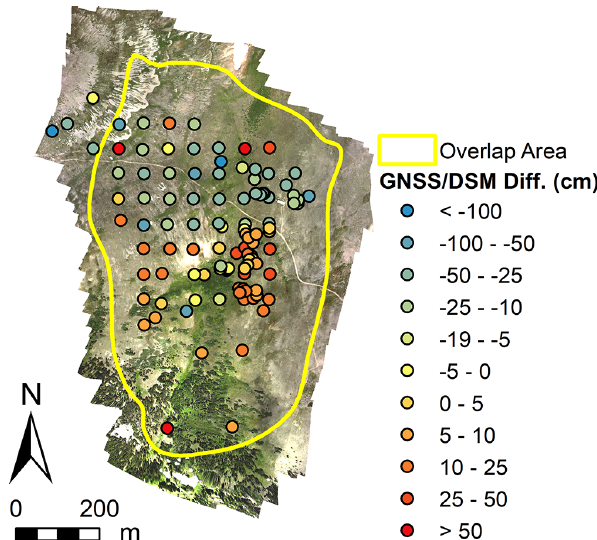
Figure 10. Spatial distribution of vertical errors for the 14 August DSM (GNSS ellipsoid height at surveyed check points minus DSM ellipsoid height). Negative values indicate that DSM elevation is greater than GNSS-surveyed